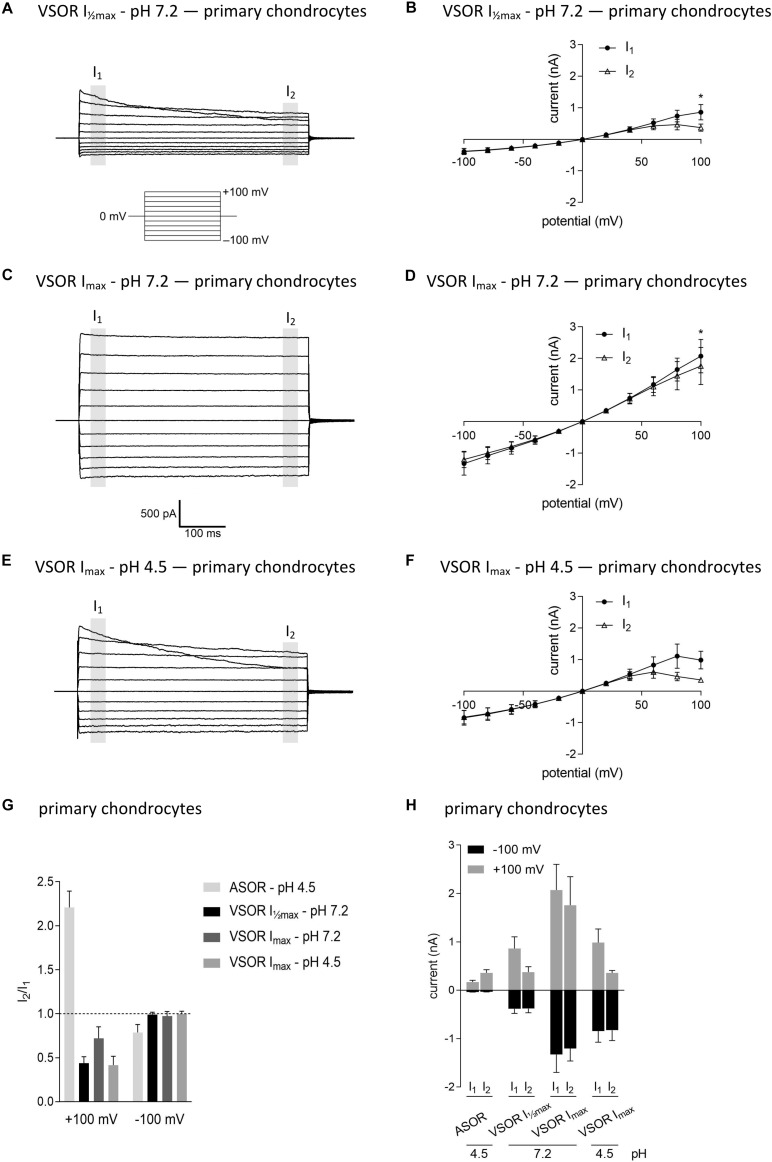
The volume-sensitive outwardly rectifying (VSOR) current in primary chondrocytes is affected by low pH. VSOR current traces elicited by 500-ms voltage steps from –100 mV to +100 mV obtained at half-maximal VSOR current amplitudes (VSOR Imax—pH 7.2) (A), at maximal VSOR current amplitudes (VSOR Imax—pH 7.2) (C), and at maximal VSOR current amplitudes immediately after reducing pHe to 4.5 (VSOR Imax—pH 4.5) (E). (B,D,F)
I–V relationships of mean VSOR currents analyzed at the beginning (I1—closed circles) and at the end (I2—open triangles) of voltage pulses (indicated by gray shadings in A, C, and E). (B) VSOR Imax—pH 7.2 (n = 5). (D) VSOR Imax—pH 7.2 (n = 6). (F) VSOR Imax—pH 4.5 (n = 3). Asterisks indicate significant differences between I1 and I2 (p < 0.05). Paired t-tests. (G,H)
I2/I1 ratios and mean current amplitudes, respectively, of ASOR currents and VSOR Imax—pH 7.2, VSOR Imax—pH 7.2, and VSOR Imax—pH 4.5 currents at +100 and –100 mV. Means ± SEM. (G)
n = 3–7 (I2/I1 ratio > 1, time-dependent activation; I2/I1 ratio < 1, time-dependent inactivation). (H)
n = 2–3.